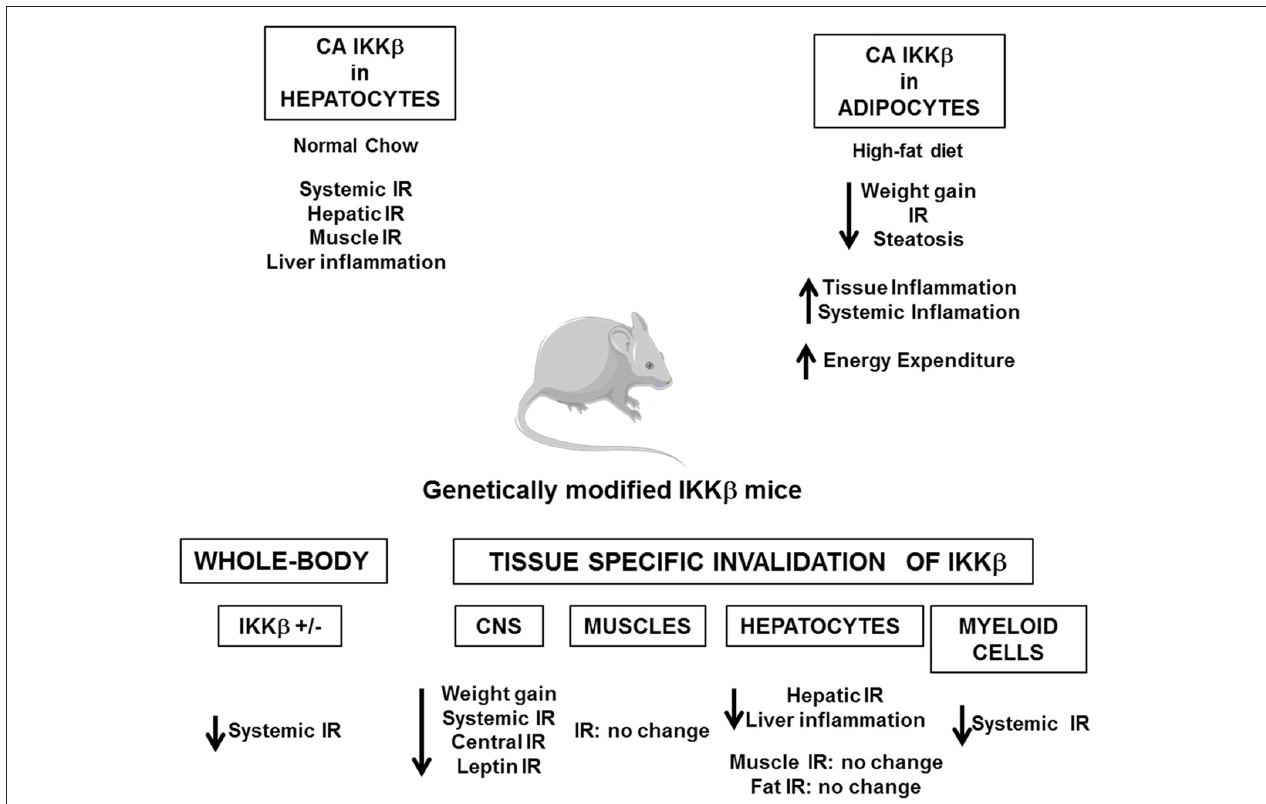
or of mice with a tissue specific inactivation of IKK β in the central nervous system (CNS), hepatocytes, myeloid cells, or muscles demonstrates that activation of IKK β /NF- κ B pathway is a core mechanism that connects metabolic inflammation and insulin resistance in peripheral metabolic tissues, except muscles, and in the central nervous